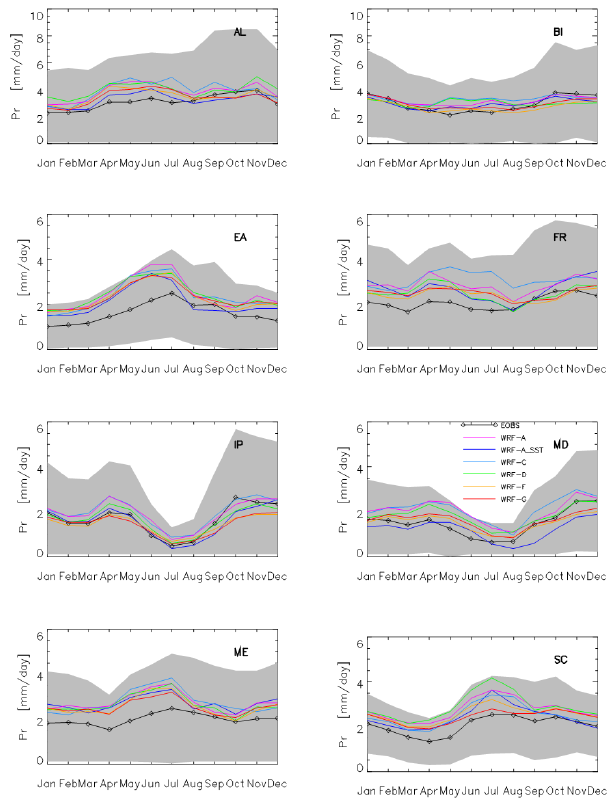
Figure 4. Mean precipitation annual cycle. The grey area indicates observational standard deviation.